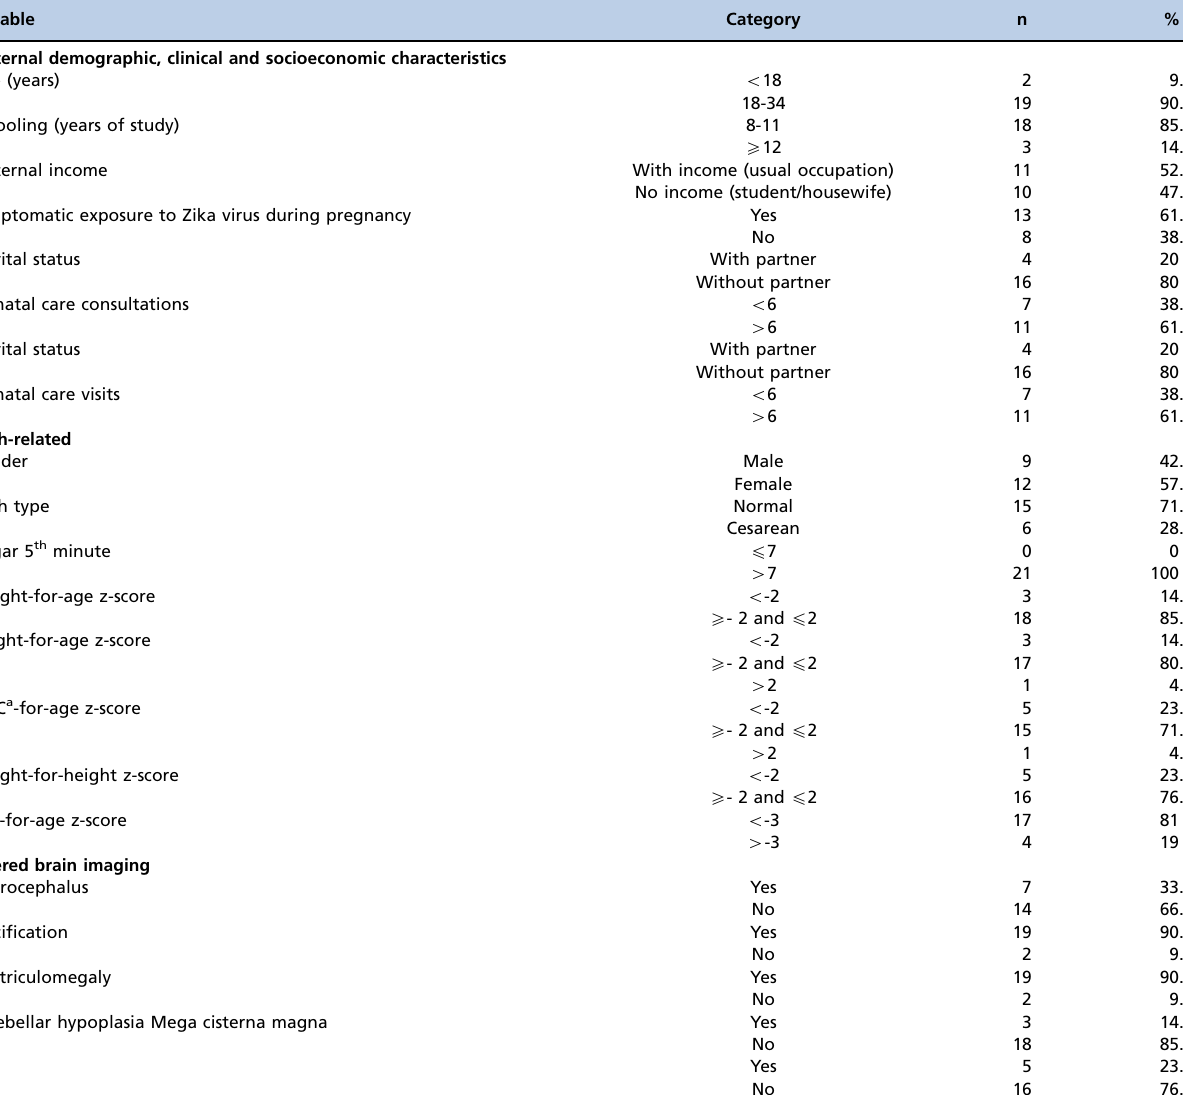
Table 1 - Demographic, socioeconomic and clinical characteristics of mothers and their microcephalic newborns hospitalized at the IFF/Fiocruz, Rio de Janeiro, from February to September 2016. Variable Category Maternal demographic, clinical and socioeconomic characteristics Age